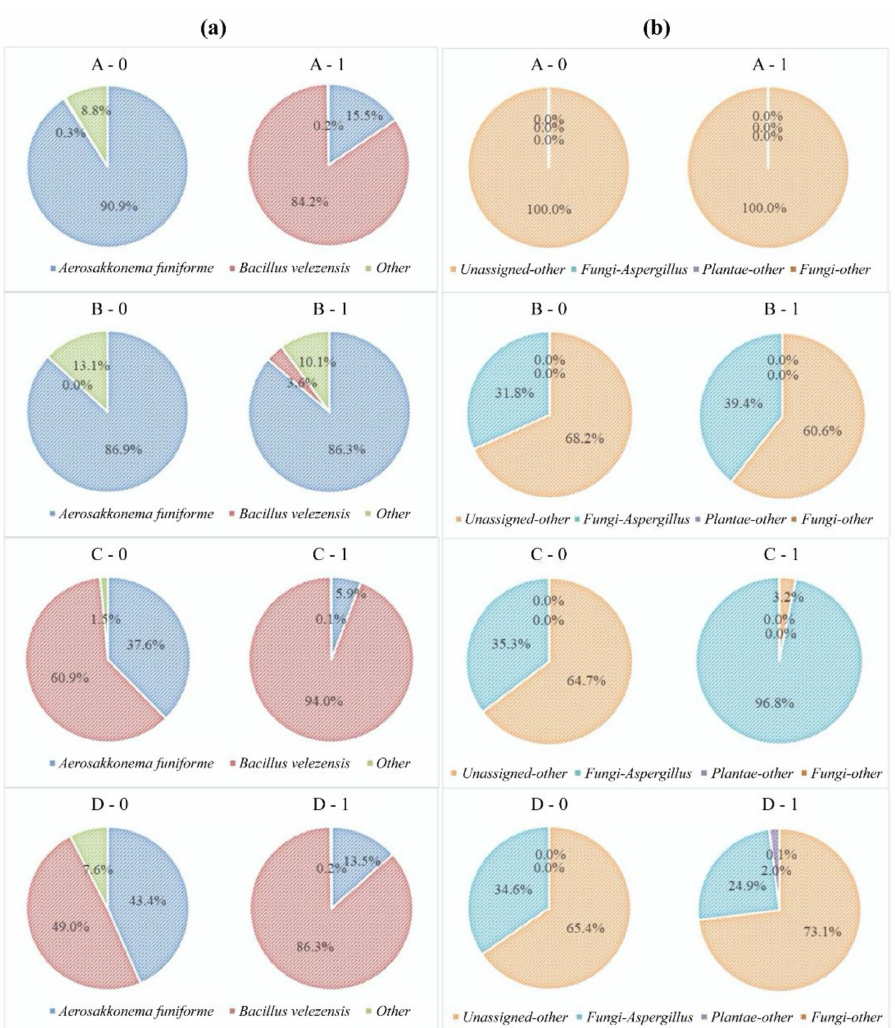
Figure 1. Taxonomic classification at the species level of the ( a ) bacterial 16S rRNA gene and ( b ) fungal ITS gene reveals changes in bacterial and fungal communities during one-day fermentation. The experimental groups were inoculated as follows: A, control without starter; B, Aspergillus oryzae single inoculation group; C, Bacillus velezensis and A. oryzae individual inoculation group; and D, B. velezensis and A. oryzae co-inoculation